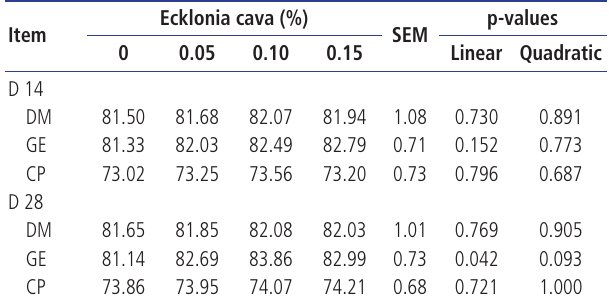
Table 3. Effects of supplemental Ecklonia cava on growth performance of weanling pigs